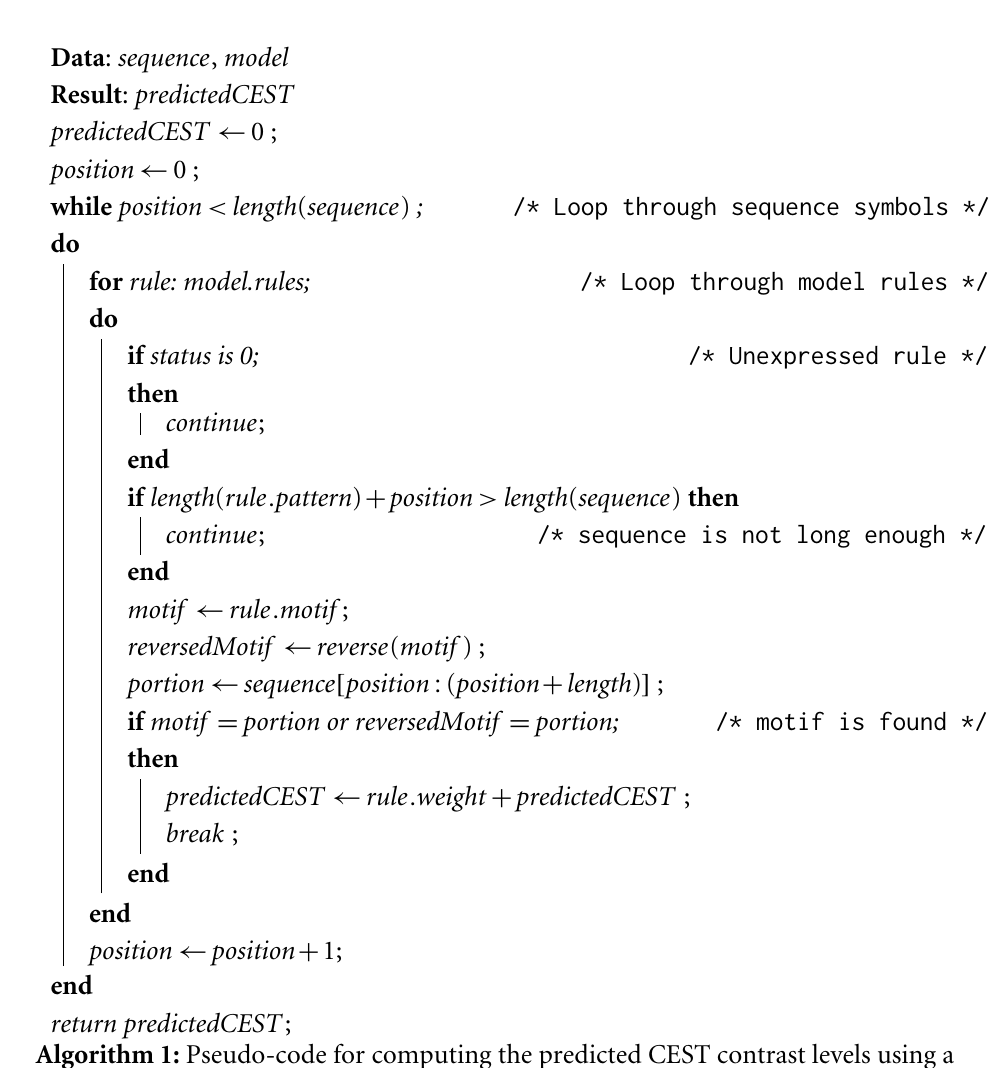
Algorithm 1: Pseudo-code for computing the predicted CEST contrast levels using a POET model. length() represents a function returning the size of a given input string ar- ray. This algorithm takes a protein sequence and a predicting model as input to output the predicted CEST contrast